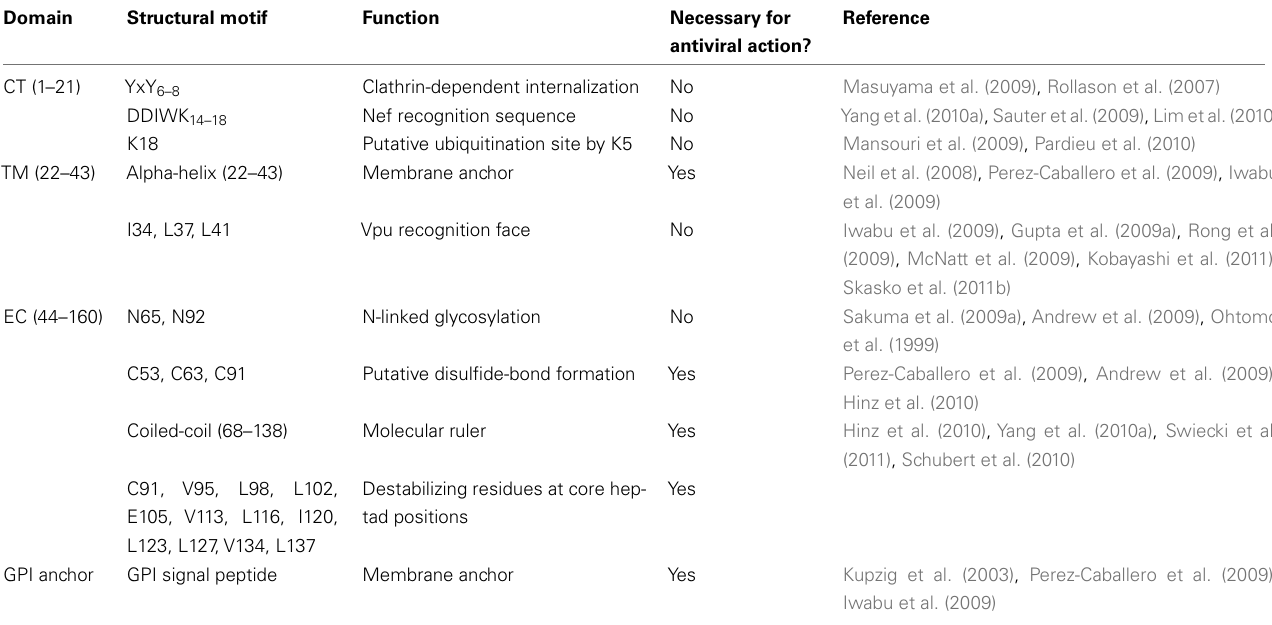
Table 1 | Salient structural features of human